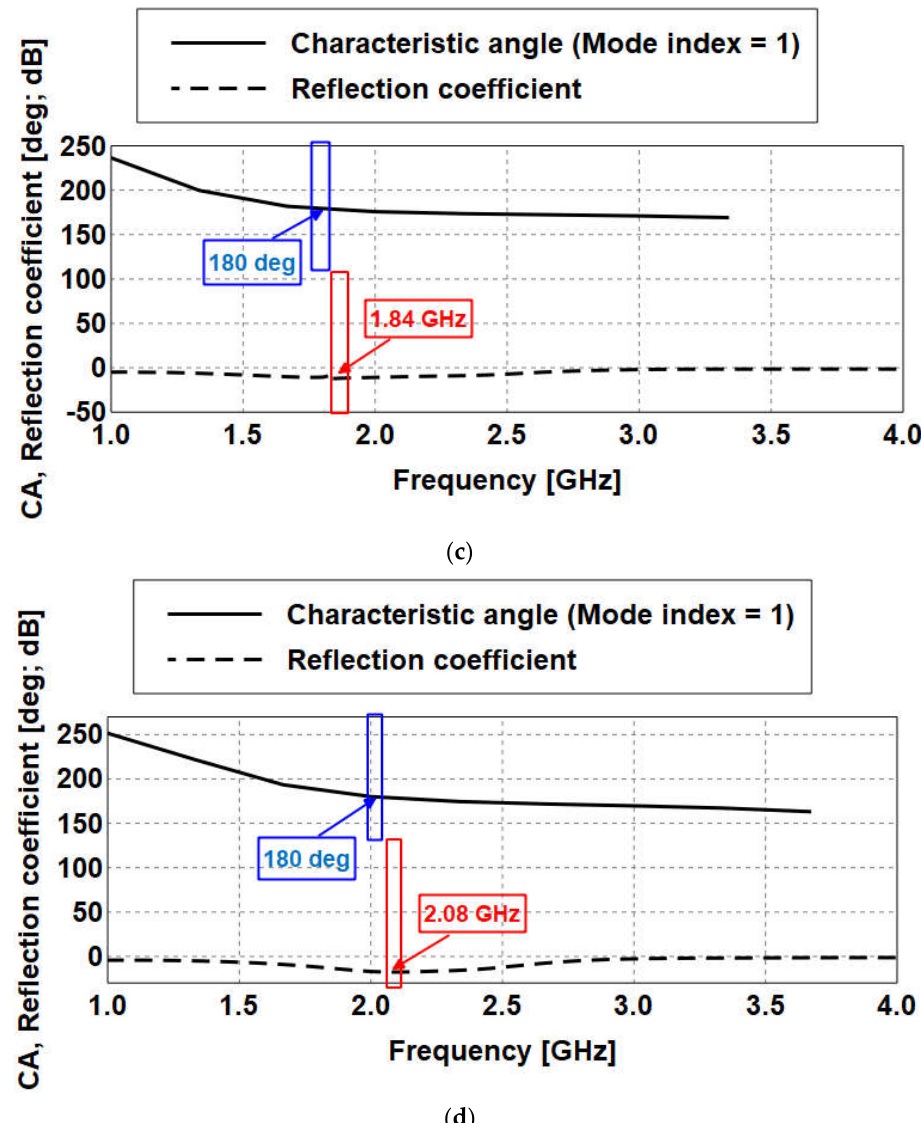
Figure 7. Characteristic angle and reflection coefficients of the patch with CRS on different substrates: